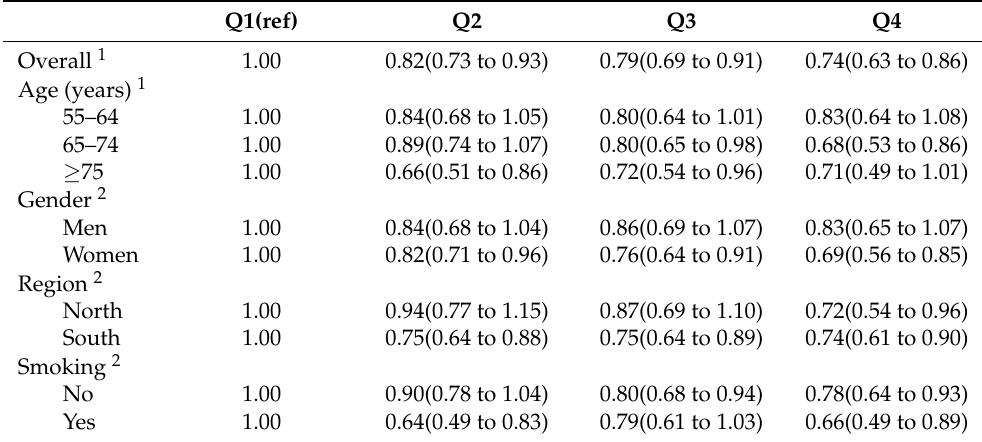
Table 4. Adjusted odds ratios (95% CIs) for global cognitive score below nine across quartiles of “vegetable-pork” pattern score among Chinese adults aged ≥ 55 years old attending China Health and Nutrition Survey between 1997 and